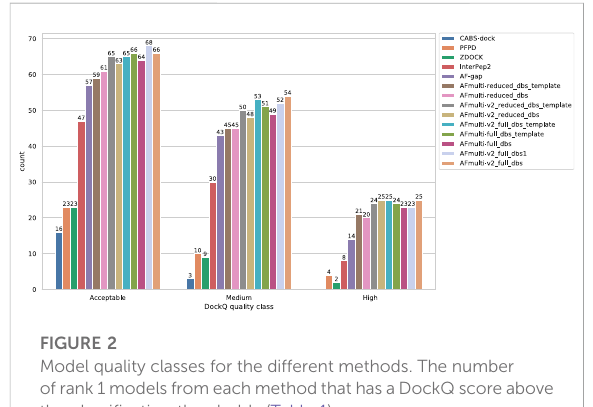
FIGURE 2 Model quality classes for the different methods. The number ofrank 1 modelsfrom each method that has aDockQ score above the classi fi cation thresholds (Table 1).